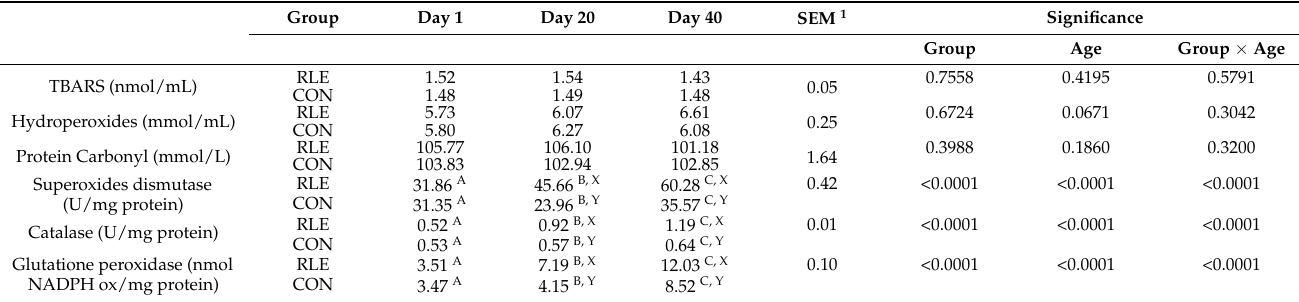
Table 8. Effect of including RLE in the diet during the growing of the kid’s plasma TBARS, hydroperoxides, protein carbonyl, superoxide dismutase, catalase, and glutathione peroxidase oxidative parameters. Group Day 1 Day